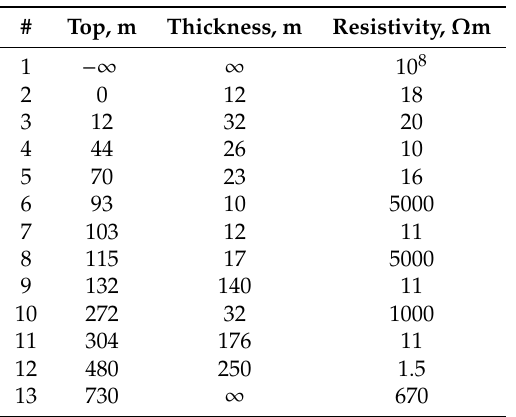
Table 2. The reference 1D resistivity